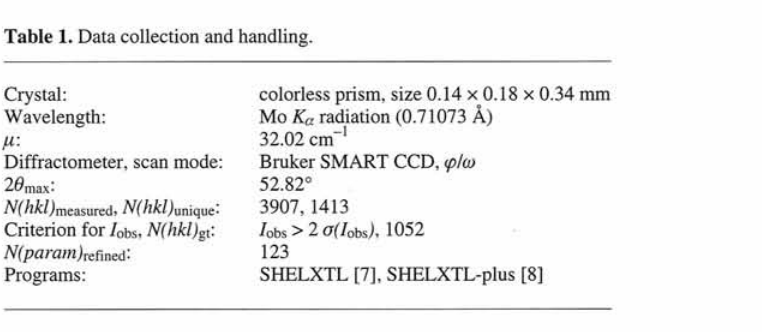
Table 2. Atomic coordinates and displacement parameters (in